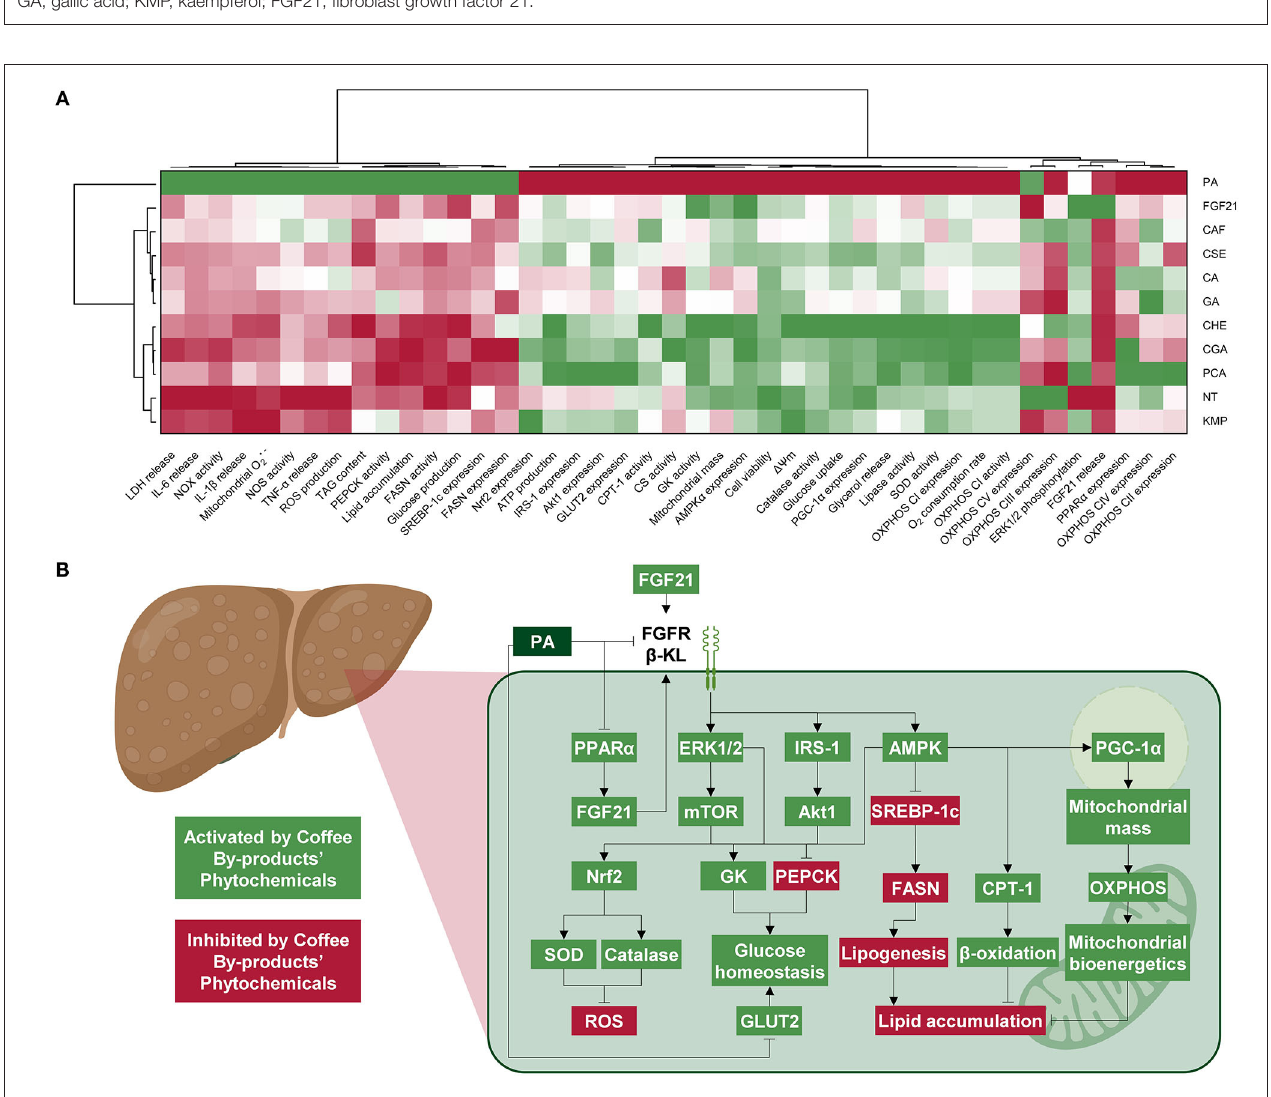
FIGURE 9 | Integrative hierarchical cluster analysis and heat map (from the lowest ( (cid:4) red) to the highest ( (cid:4) green) value for each parameter) unifying all parameters demonstrates that chlorogenic and protocatechuic acids are the bioactive compounds exhibiting the highest NAFLD-protecting effects (A) . Diagram illustrating the molecular mechanisms from the effects of the bioactive compounds in coffee by-products on hepatic FGF21 signaling, oxidative stress, mitochondrial bioenergetics, and energy metabolism (B) . NT, non-treated cells; PA, palmitic acid; CAF, caffeine; CGA, chlorogenic acid; CA, caffeic acid; PCA, protocatechuic acid; GA, gallic acid; KMP, kaempferol; FGF21, fibroblast growth factor